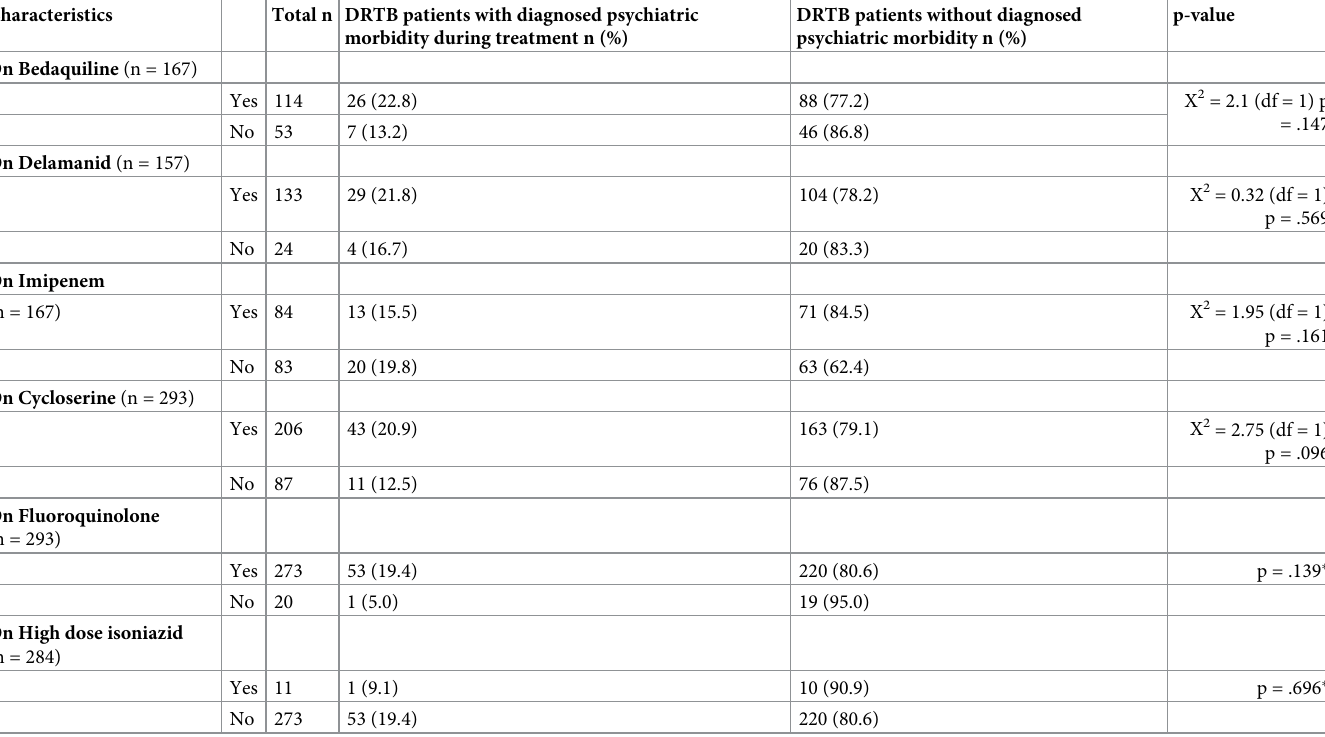
Table 3. Association between anti-TB drugs and psychiatric comorbidities among drug-resistant tuberculosis patients enrolled at Me´decins Sans Fronti è res Mum- bai clinic between January 2012 and March 2019. Characteristics